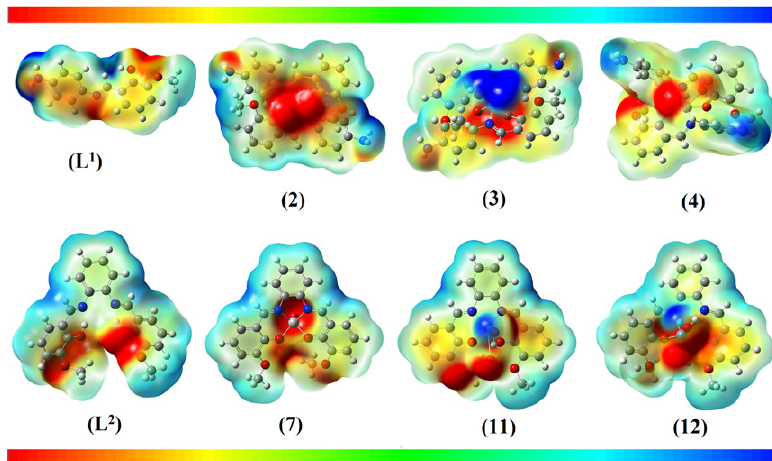
Figure 5. MEPs and colour pattern for the investigated ligands and their selected metal